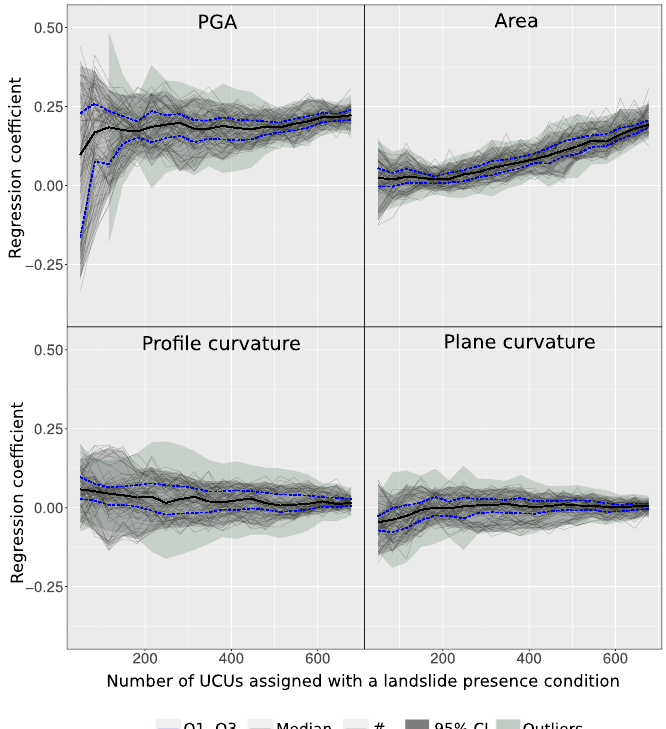
Figure A2. PGA, area, profile curvature, and plan curvature effects graphical summary at a varying proportion of landslide presence